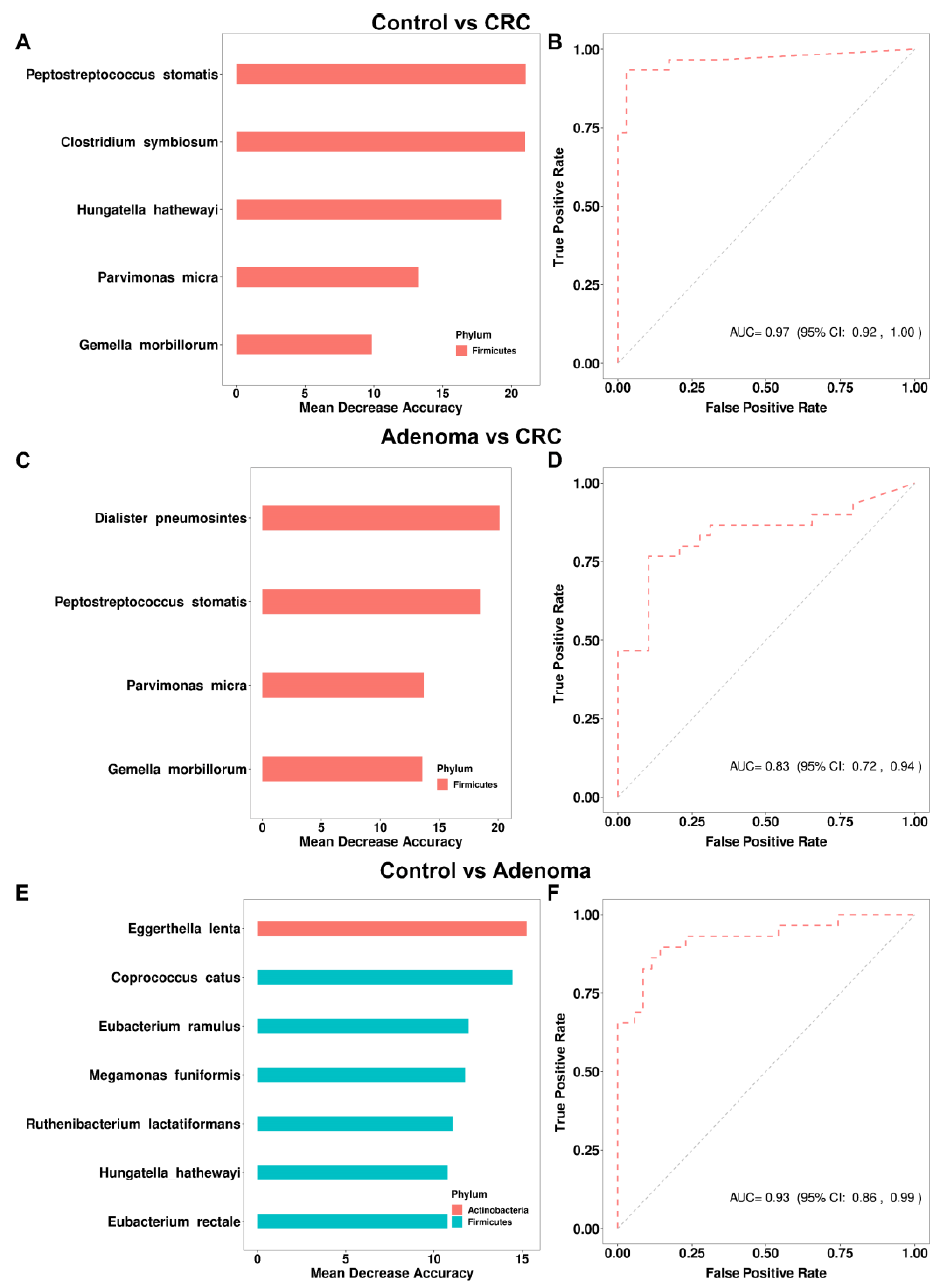
Figure 2. The prediction power of bacterial markers for colorectal adenoma and colorectal cancer. ( A ) Five bacterial markers were identified by the random forest model to discriminate CRC from control. The bar plot shows the average importance score and importance ranking of the five bacteria (measured by mean decrease in accuracy). ( B ) The prediction performance of the bacterial classifier for the classification of CRC and control in our discovery data showed by the area under the curve (AUC) of receiver operating characteristic (ROC). ( C ) Four bacterial markers were identified by the random forest model to discriminate CRC from CRA. The bar plot shows the average importance score and importance ranking of the four bacteria. ( D ) The ROC curve of the classifier for classification of CRC and CRA status in our data. ( E ) Seven bacterial markers were identified by the random forest model to discriminate CRA from control. The bar plot shows the average importance score and importance ranking of the seven bacteria. ( F ) The ROC curve of the classifier for classification of adenoma and control in our data. The legends in Figure 2A,C,E indicate the phylum to which the bacterium